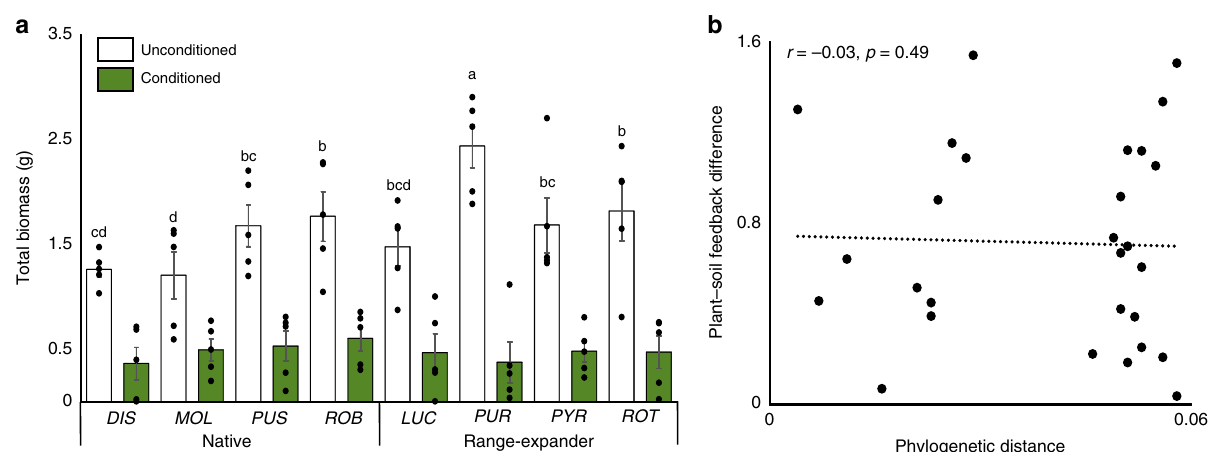
Fig. 3 Plant – soil feedback. a Plant biomass of eight Geranium species in soils conditioned by conspeci fi cs (green) or in unconditioned soils (white) ( N = 5 per species). Native plant species are G. dissectum ( DIS ), G. molle ( MOL ), G. pusillum (PUS), and G. robertianum ( ROB ) and range-expanding plant species are G. lucidum ( LUC ), G. pyrenaicum ( PYR ), G. purpureum ( PUR ), and G. rotundifolium ( ROT ). Bars and whiskers represent average biomass ± SEs as examined using a general linear model. Small letters show post-hoc test results between plant species in unconditioned soils. b Absolute between-species differences